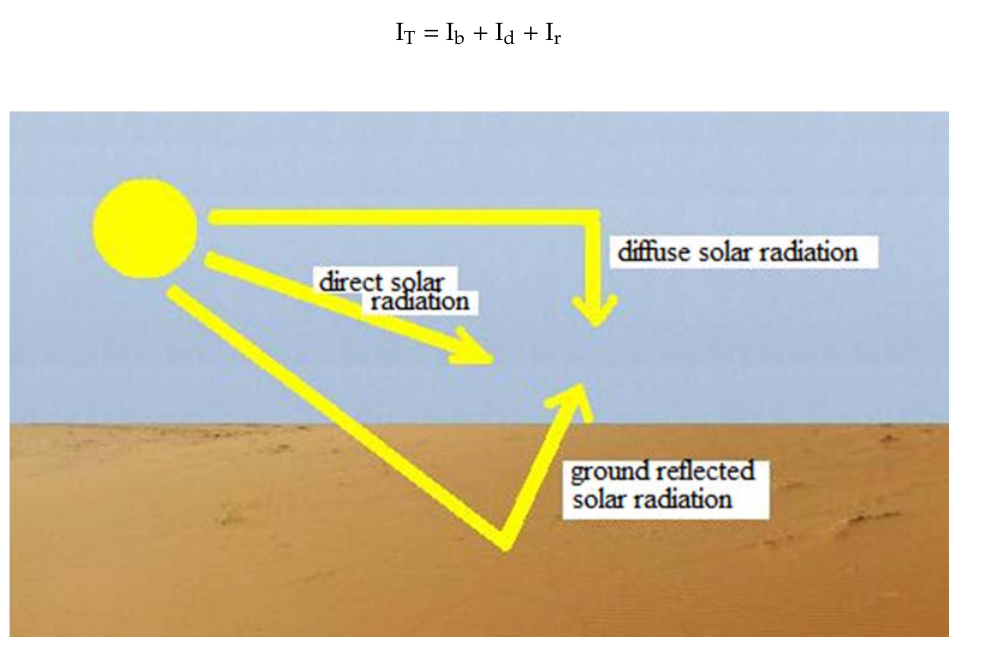
Figure 1. Scheme of direct solar, diffuse solar and ground albedo solar radiations.